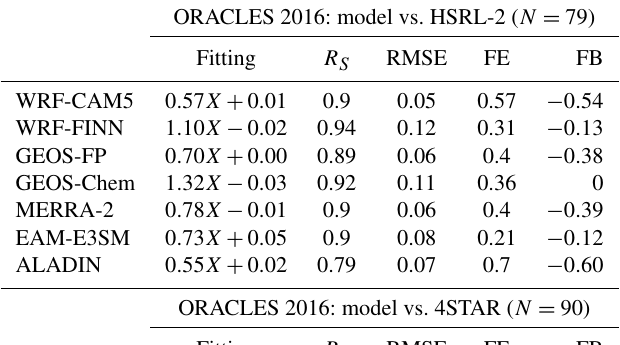
Table 2. A statistical summary of the scatterplots between Figs. 10 and 13. The sample size of each comparison ( N ) is indicated in the